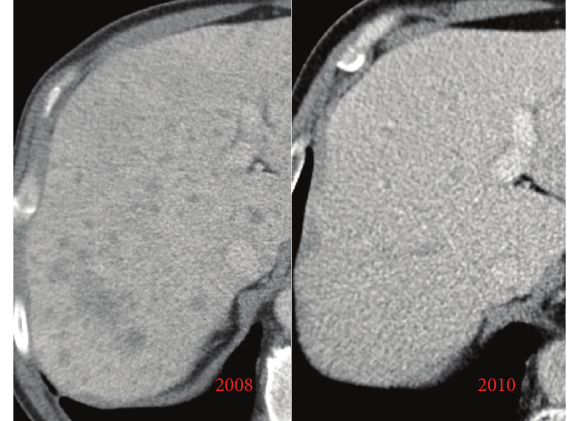
Figure 8: Axial contrast-enhanced abdominal CT images: compar- ison of CT abdominal images from 2008 and 2010 after chemother- apy, demonstrating resolution of the liver nodules, common in acute liver involvement of